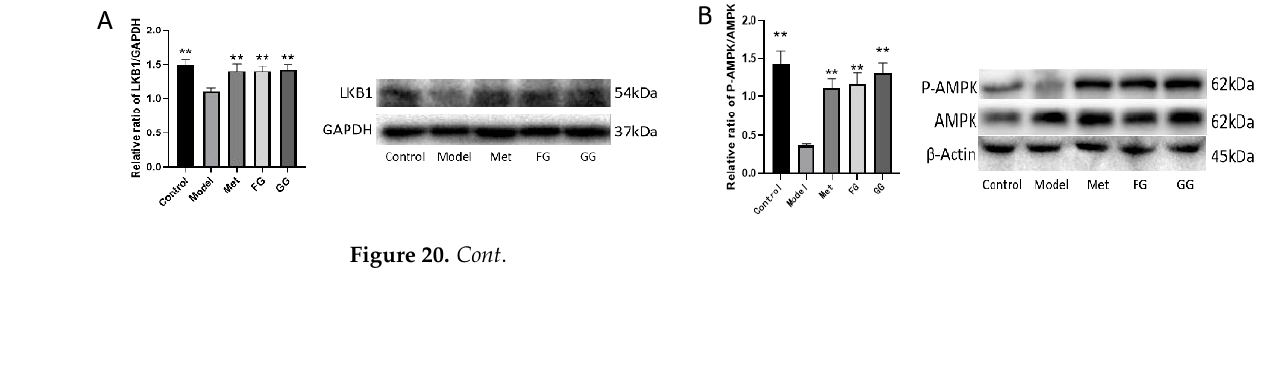
Figure 20. Effects of GG polysaccharide and FG polysaccharide on liver protein expression in db/db mice (( A ). LKB1; ( B ). P-AMPK/AMPK; ( C ). P-TSC2/TSC2; ( D ). P-mTOR/mTOR; ( E ). PPAR gamma. * p < 0.05, ** p < 0.01 compared with the model group). 4. Discussion GG and FG have the ability to raise body fluids and quench thirst according to the Chinese Pharmacopoeia [11]. The hypoglycemic effect of the flavonoid extracts of these